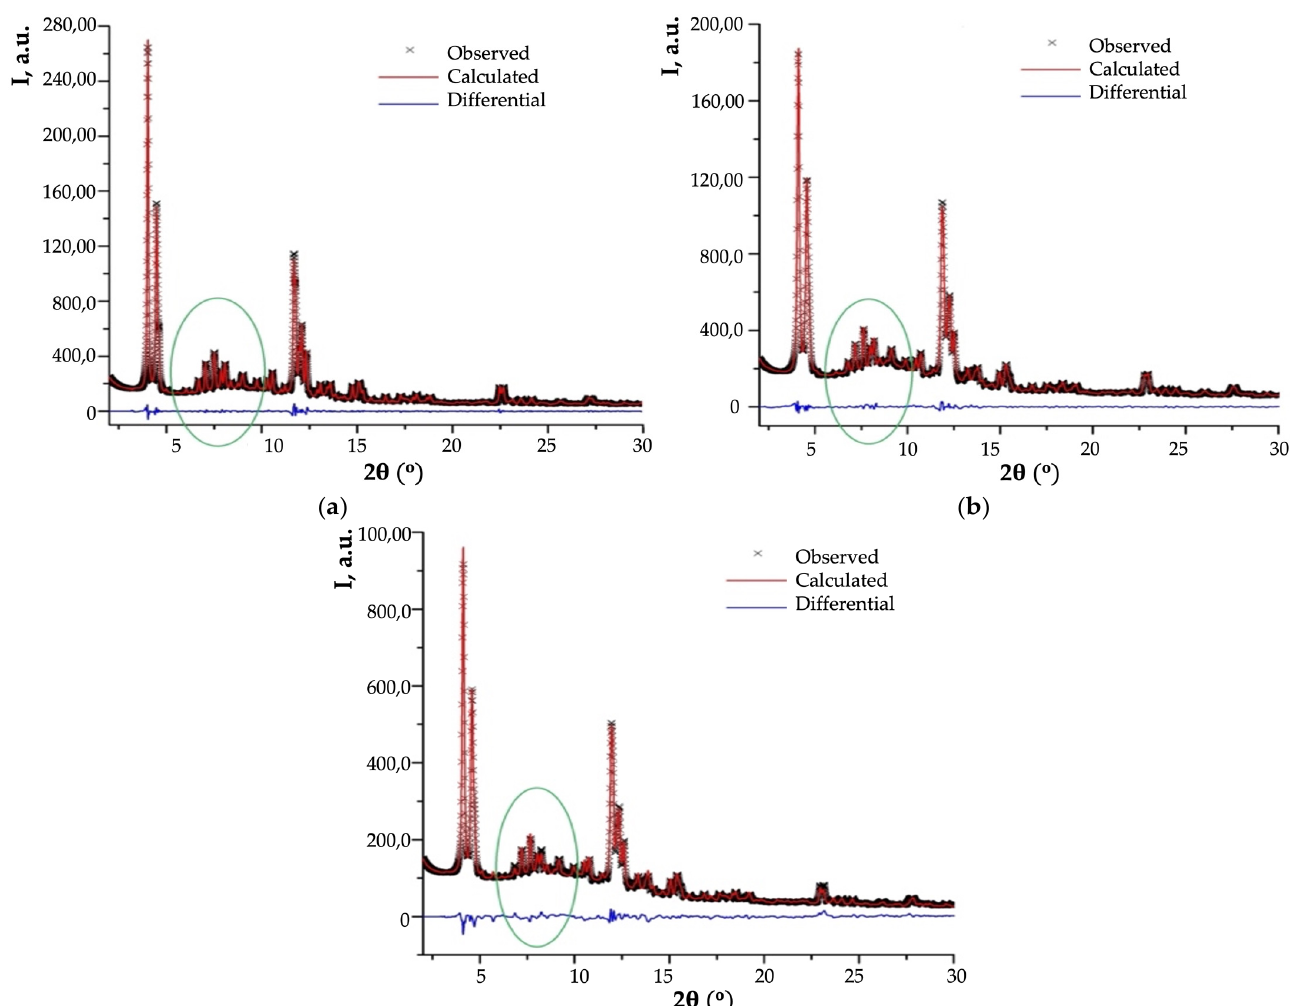
Figure 15. Final profile fit obtained for sample TS-1 ( a ), TS-2 ( b ), and TS-3 ( c ), (adapted from [33,34]). The maximal intensity of amorphous region in X-ray diffraction pattern (XRPD) of the studied samples (Figure 15) is ~5.0% and ~4.5% of most intense peak for TS-2 and TS-3, ~2.4% for TS-1, and the intensity for other samples (TS-1(348), TS-2(348), and TS-3(348)) is much lower. This fact means than amorphous formations decompose after performed thermal treatment of TS-1, TS-2, and TS-3 samples. In this regard, Bragg peaks of impurity anatase are absent in all diffraction patterns.